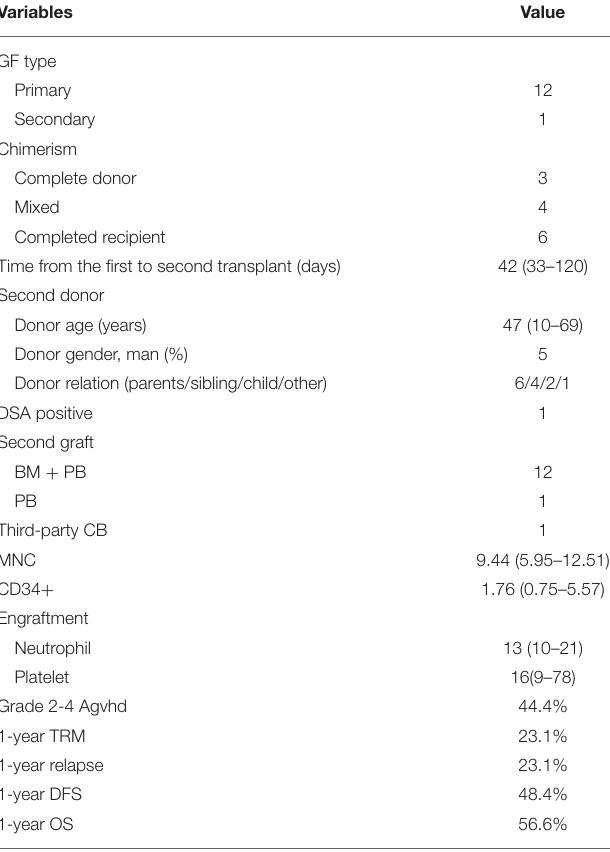
TABLE 2 | Summary of the second transplantation.